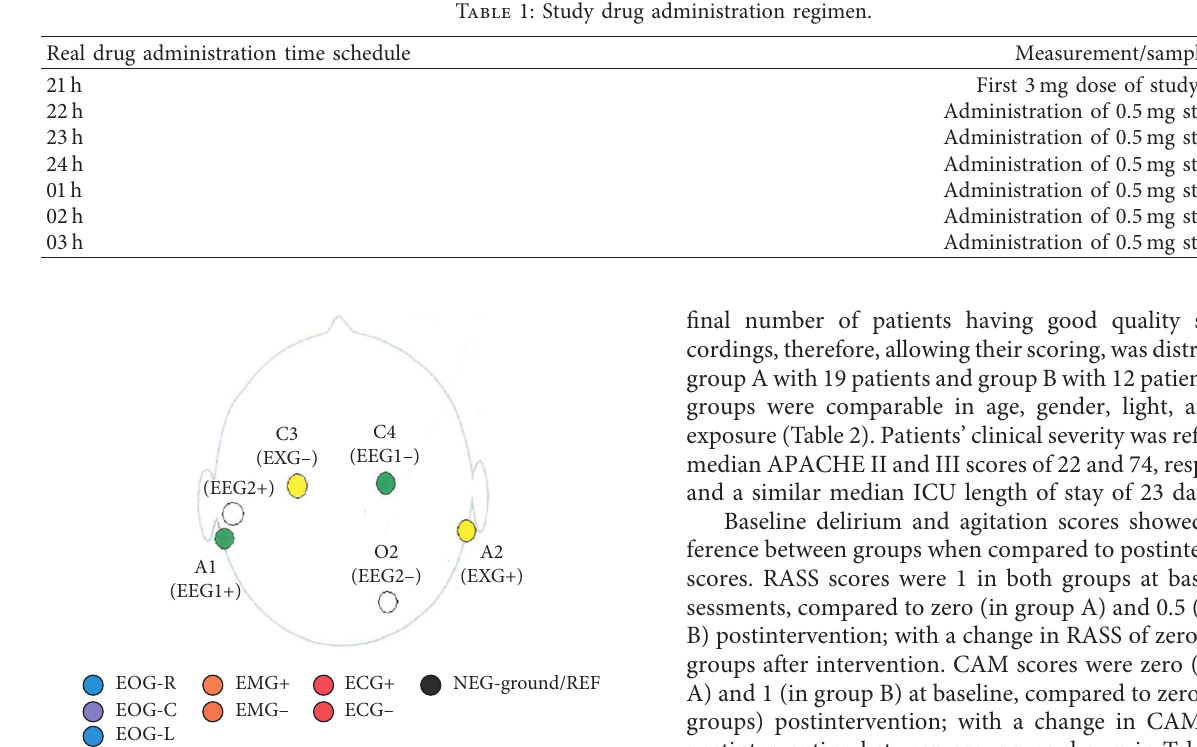
Figure 1: Polysomnogram montage. Basic six channels EEG montage for ICU-sleep studies with additional electroocular (EOG) leads in both eyes and electromyogram (EMG) at the trapezius muscles